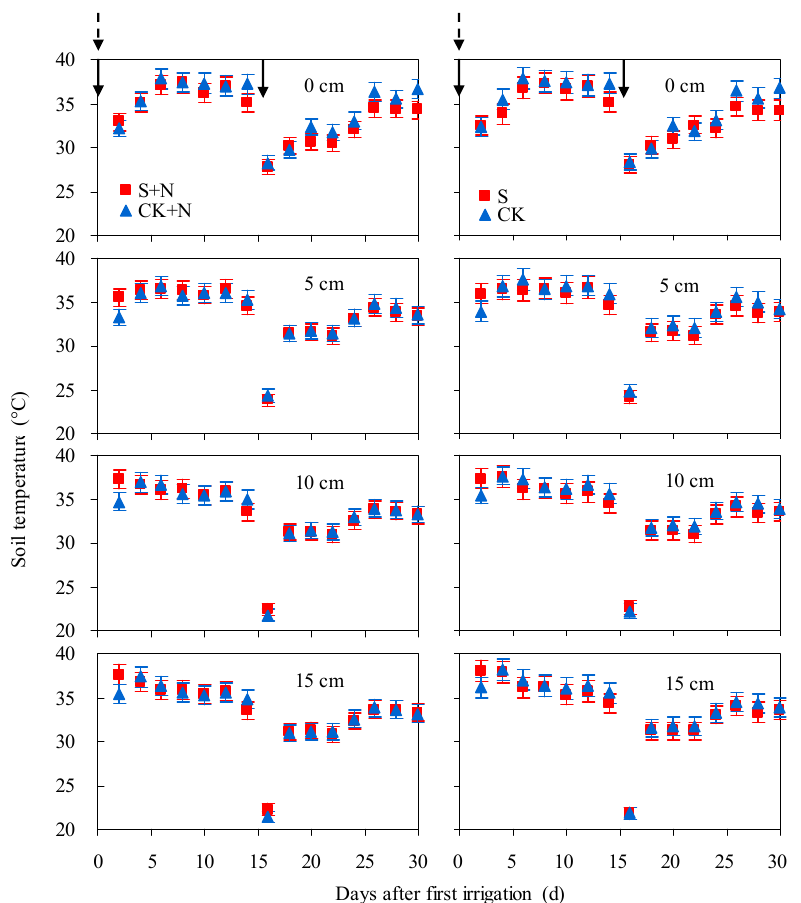
Figure 2. Soil temperature at 0, 5, 10 and 15 cm layers after two irrigation events from 20 July to 18 August. Solid arrow and dotted arrow represent irrigation and fertilization event, respectively. S + N and S means the average soil temperature from three saline water irrigated soils (S2, S5 and S8) with N120 and N0 application, respectively.